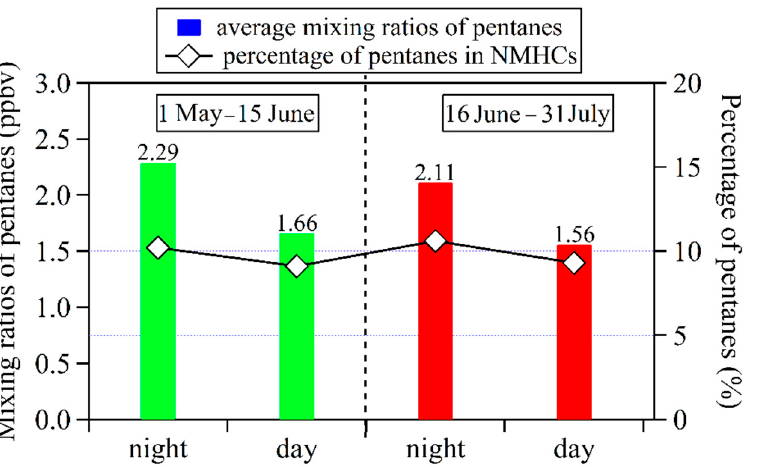
Figure 7. Average mixing ratios and percentages of pentanes during daytime (06:00–20:00) and